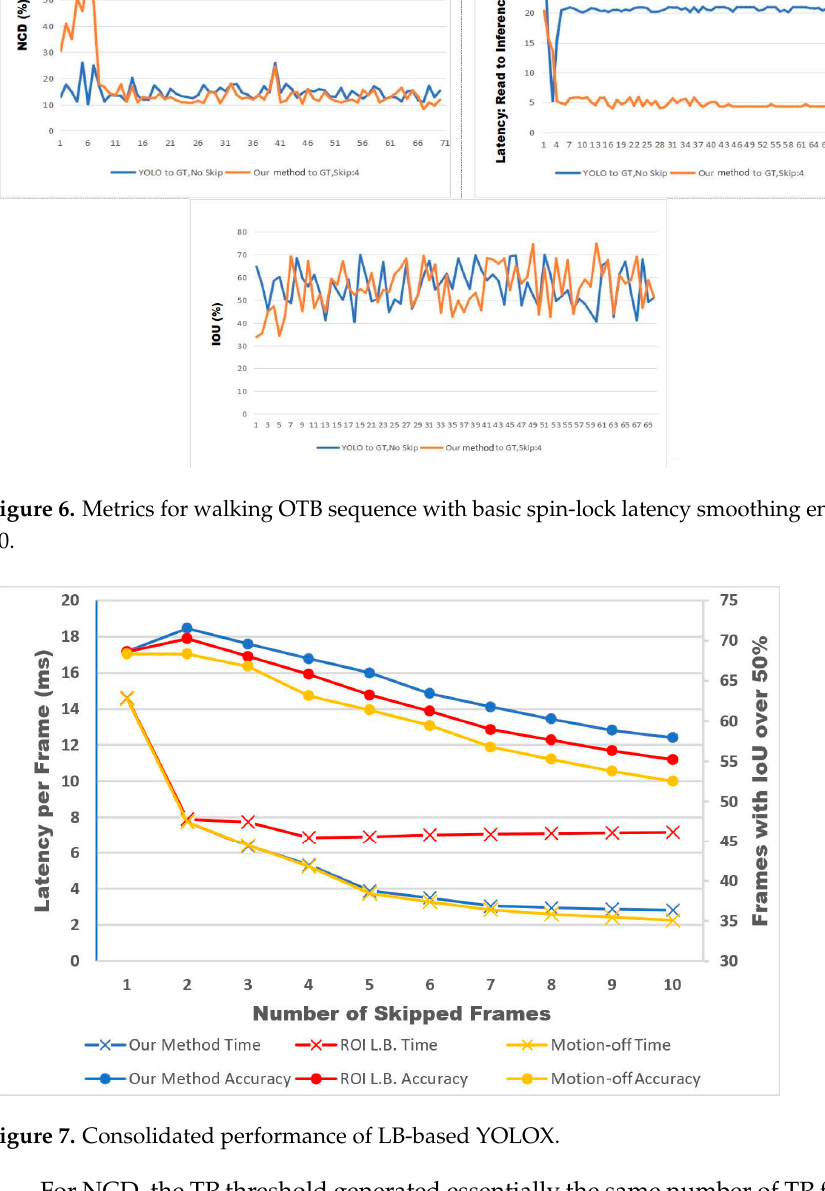
Figure 7. Consolidated performance of LB-based YOLOX.